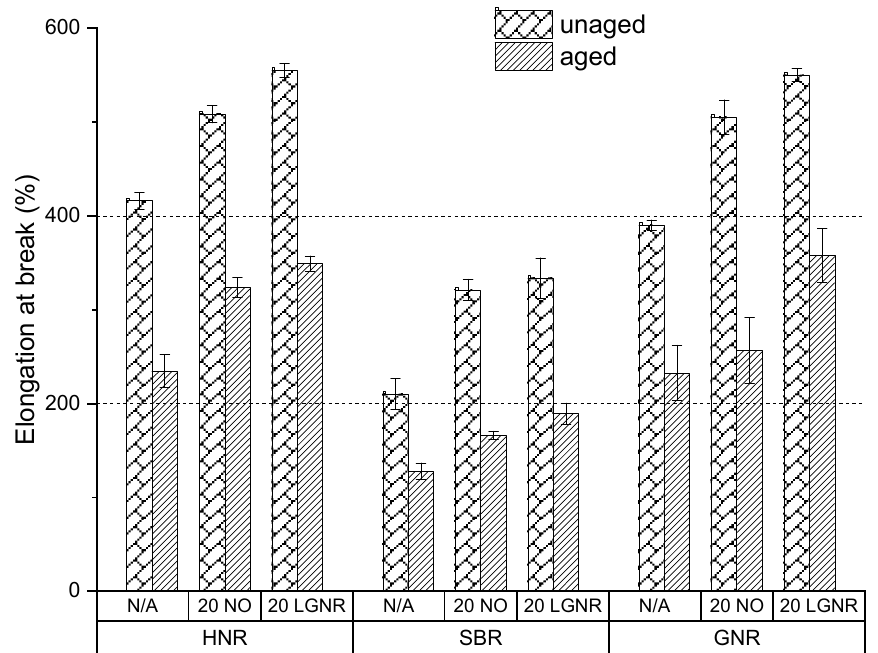
Figure 16. Aging effects on the elongation at break of HNR, SBR and GNR composites made with or without processing aids. N/A: rubber compounds without processing aids; 20 NO: rubber compounds with 20 phr naphthenic oil; 20 LGNR: rubber compounds with 20 phr liquid guayule natural